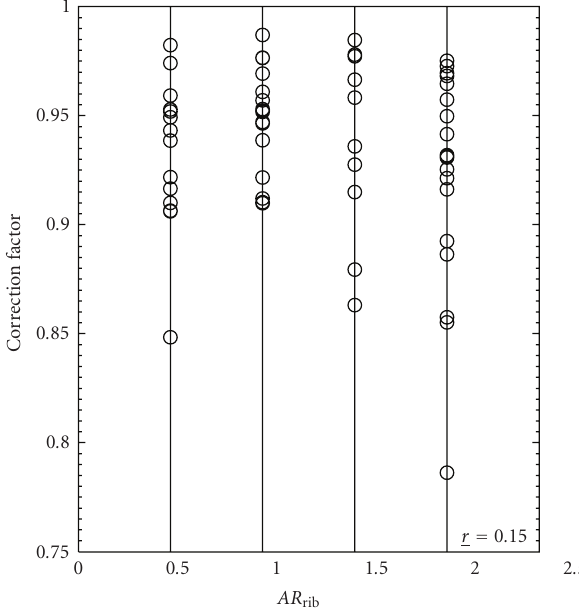
Figure 13: Correction factor variation with h floor for the set of cho- sen